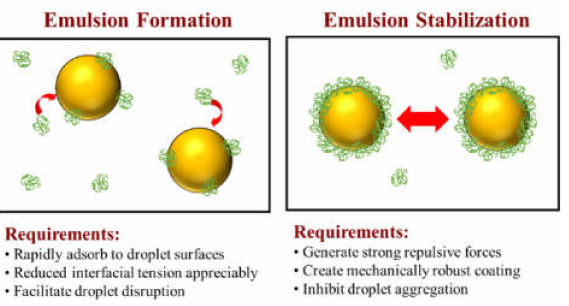
Figure 1. Protein-based emulsifiers play two major functions in the production of emulsion-based foods: facilitate emulsion formation and enhance emulsion